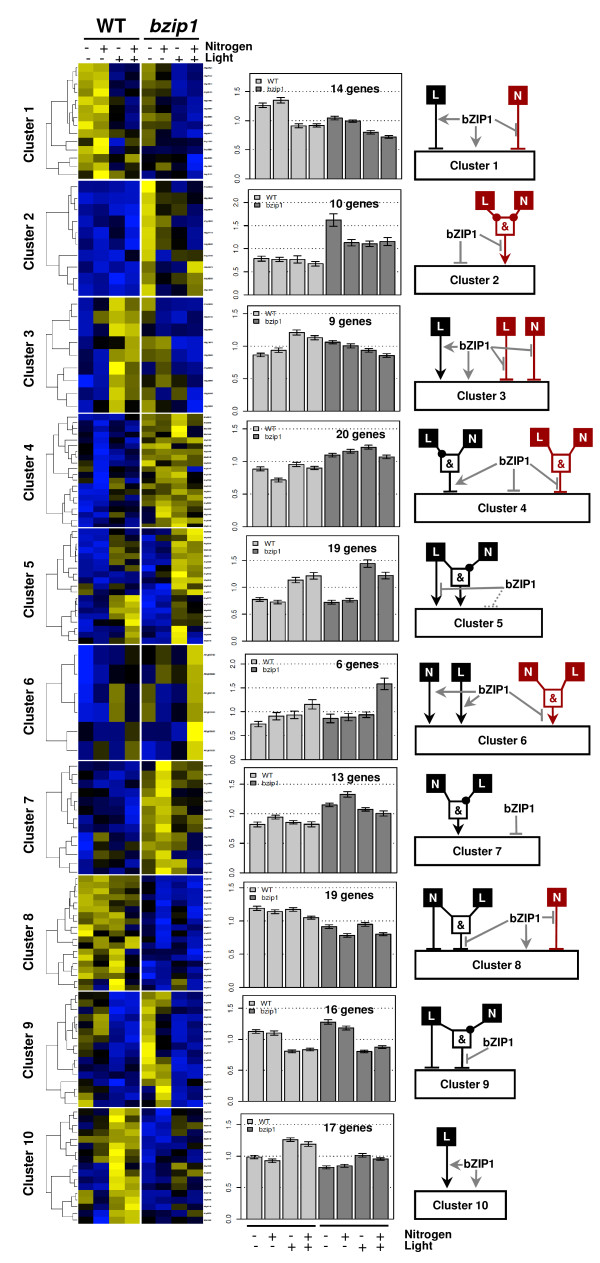
The bzip1-1 mutation triggers different modes of de-regulation in response to N and L treatments (clusters 1 to 10). ANOVA identified 219 genes misregulated in bzip1-1 compared to a WT sibling that were then used for cluster analysis (see Methods). A heatmap is presented for each cluster, with the regulation of any single gene in it and the histogram is a centroid plot of the whole cluster expression. The whole cluster has been used in order to run a second ANOVA to detect the effect of the signals and the bzip1-1 mutation (Additional file 4). The results of the second ANOVA, together with the analysis of the centroid histograms, allowed us to build a conceptual model of the role of the bZIP1 gene for each cluster/mode of de-regulation. As in Boolean logic, a black circle drawn on an edge represents the negation of the signal (for example in cluster 17: "No light and no nitrogen induces cluster expression"). To simplify the interpretation of the figure, when the logic gate uncovered using the bzip1-1 mutant plants was different from the one derived for the WT-sib, the Boolean model has been colored in red (to right side of the Boolean conceptual models).